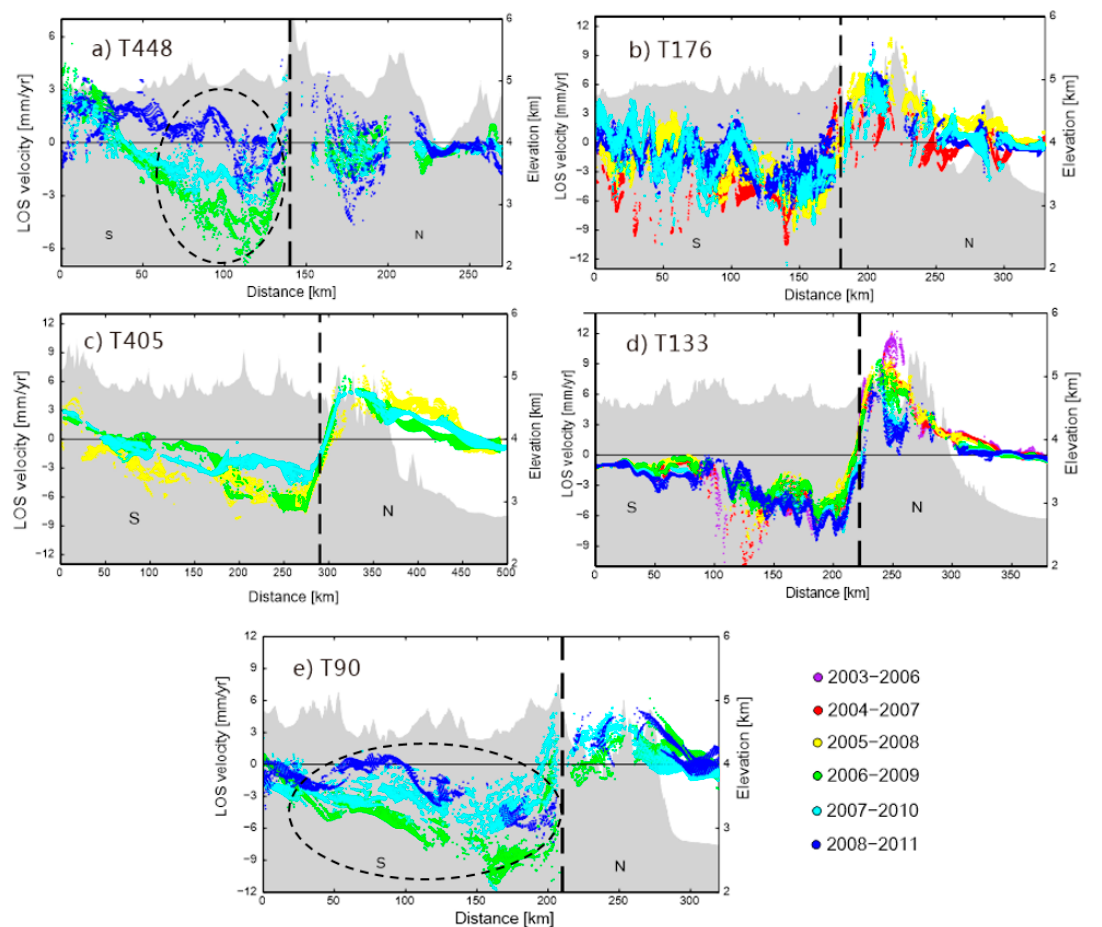
Figure 8. Comparison of postseismic velocity profiles in six periods for different segments along the KF, 448 ( a ), 176 ( b ), 405 ( c ), 133 ( d ) and 90 ( e ), (profile locations see Figure 7). The black dashed ellipses in ( a ) and ( e ) outline areas to the south of the KF where the rapid decay of postseismic deformation is clearly identified.